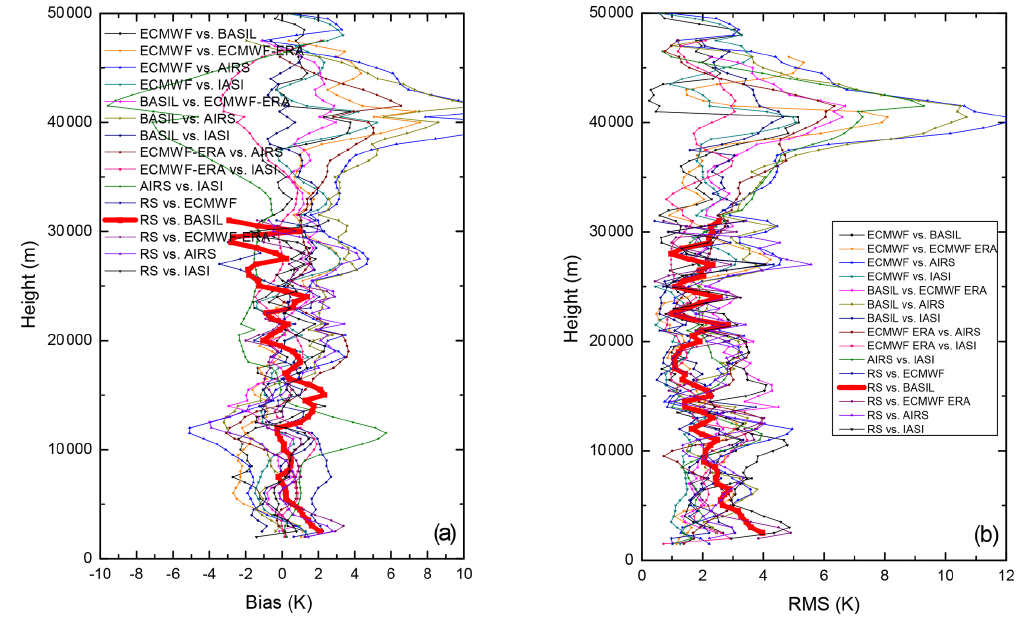
Figure 7. Vertical profiles of the temperature mean bias and RMS deviation for all sensor/model pairs: (a) bias and (b) RMS .